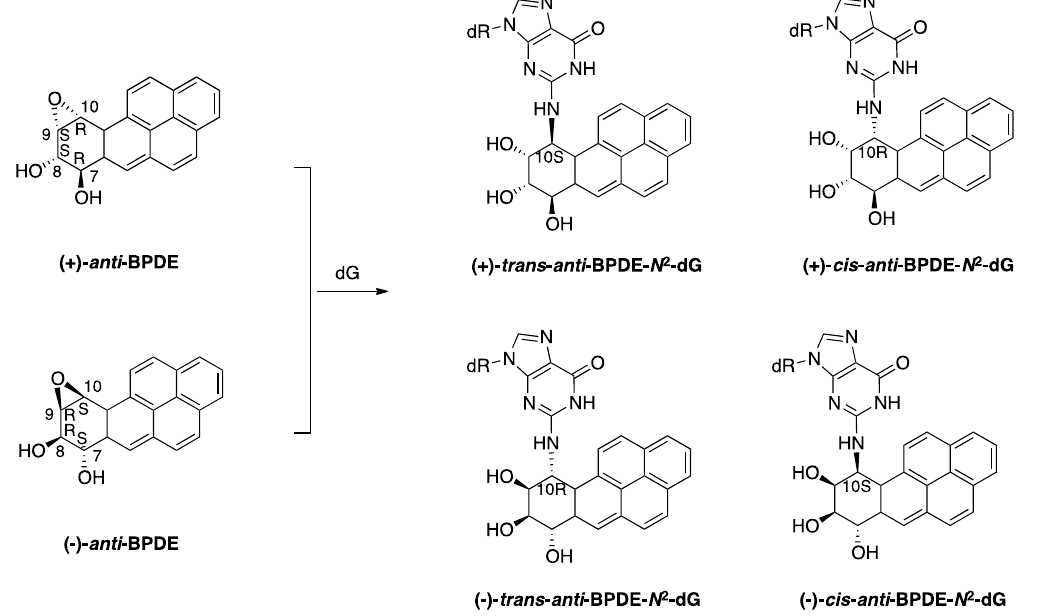
Figure 1. Structures of stereoisomers of BPDE ‐ derived N 2 ‐ dG DNA adducts.